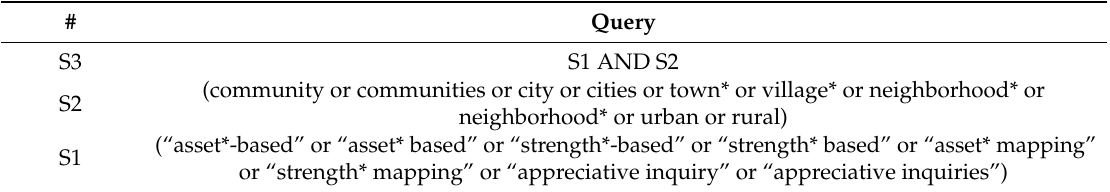
Table 1. The search